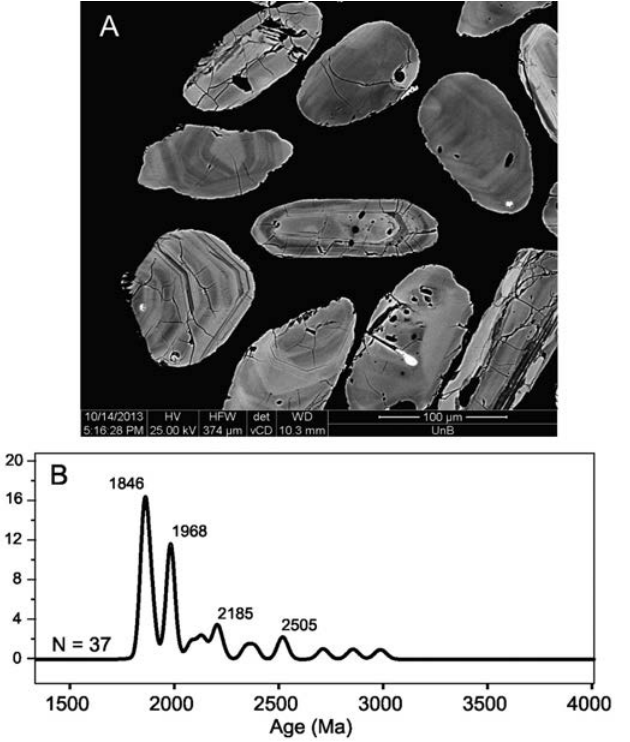
Figure 7 - Age versus epsilon e Hf plot for detrital zircon of the Novo Progresso Formation. DM = Depleted Mantle, CHUR = Chondritic Uniform